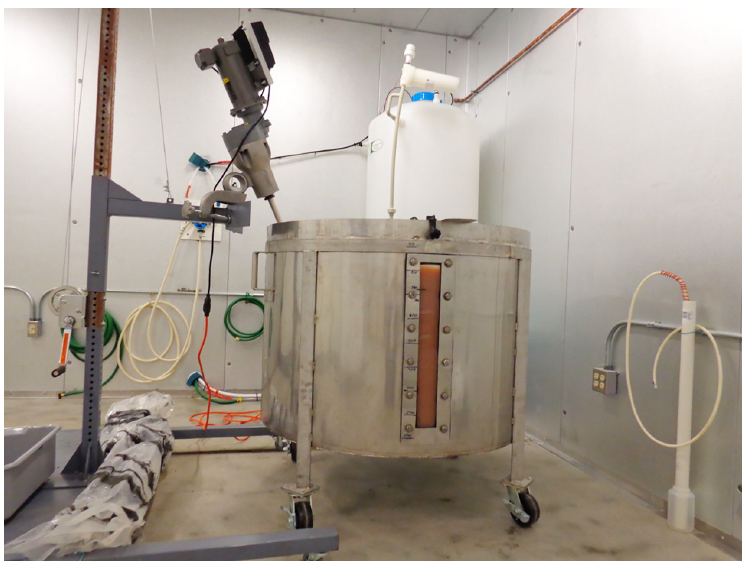
Fig 4. 1000 L stainless steel tank containing 800 L of Cohn paste suspension. The brown color of the suspension is visible through the window on the side of the tank. The stirring paddle can be winch-lifted out of the tank. The white tank behind the stainless steel tank holds cold ultrapure water that is recycled for 7 minutes every hour.